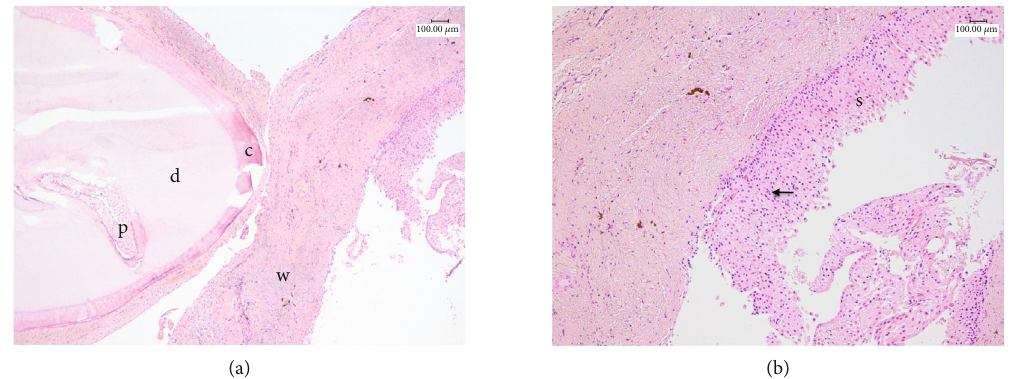
Figure 8: Representative histological pictures of the lesion. (a) The odontoma has a well-organized tooth-like structure composed mainly of dentin (d) with a thin outer layer of cement (c) and little inner dental pulp-like tissue (p). (b) It is appreciable a thin fi brous wall (w) with brown hemosiderin deposits of a cystic lesion ((a) 50x magni fi cation). At higher magni fi cation, the cyst is covered by a hyperplastic nonkeratinizing squamous epithelium (s) with exocytosis of neutrophils (arrow, (b) 100x magni fi cation) (haematoxylin-eosin